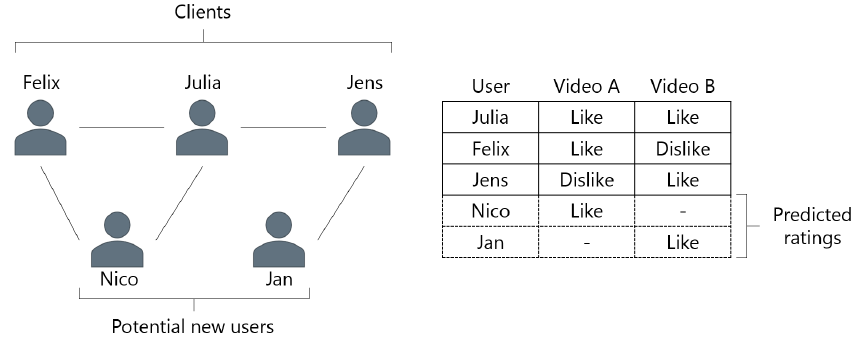
Fig. 1. Running example. A video recommendation on social